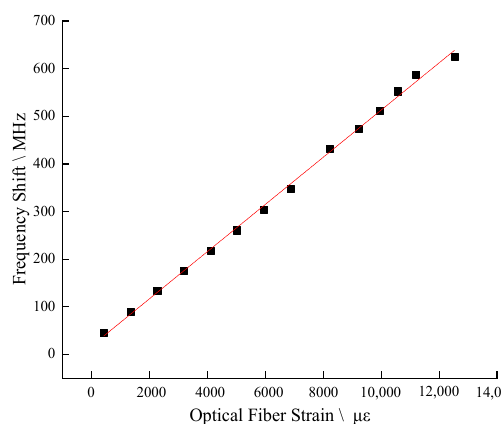
Figure 13. Strain coefficient of linear simulation.